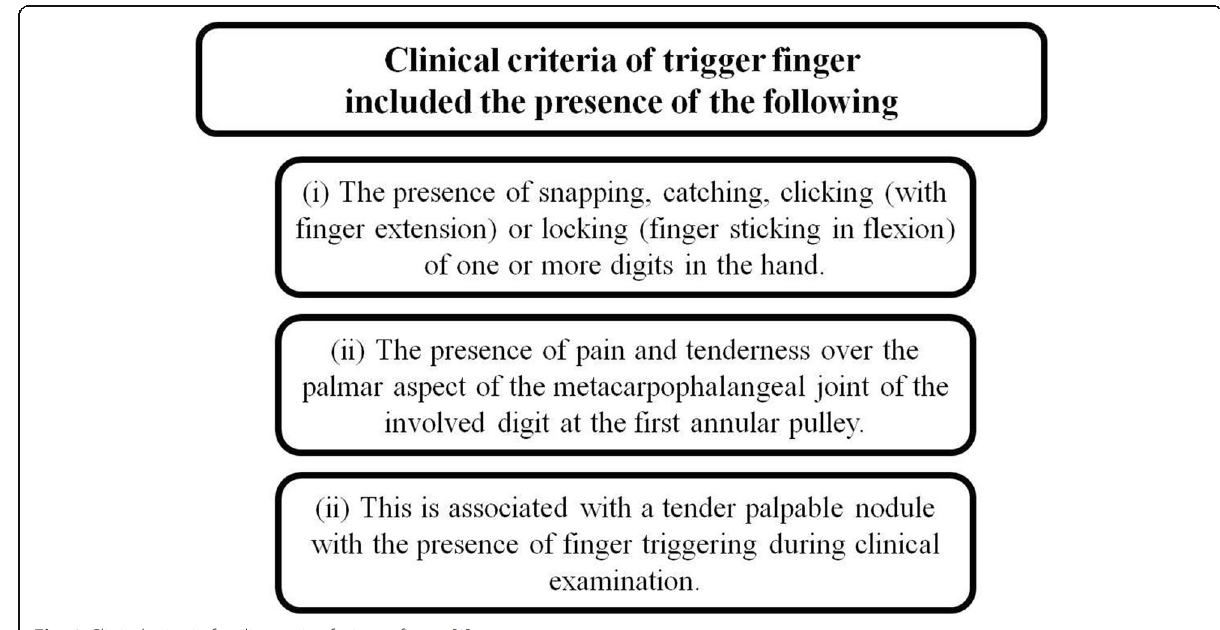
Fig. 2 Clinical criteria for diagnosis of trigger finger [9]